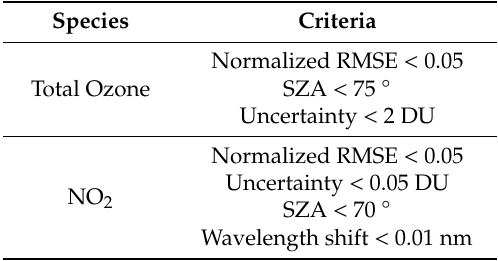
Table 1. Criteria of Data selection for